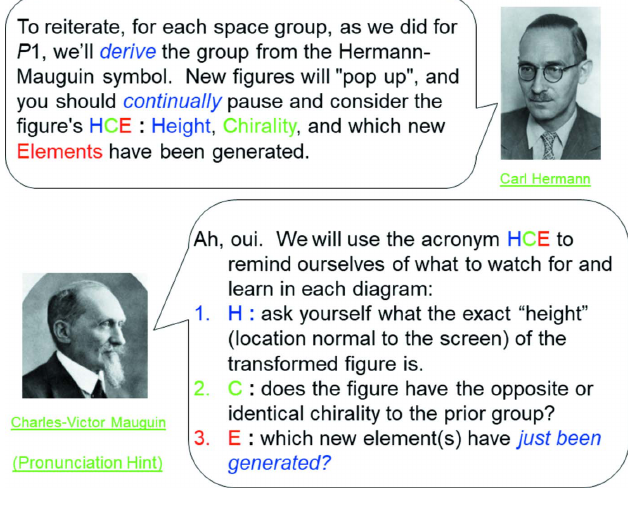
Figure 12 Slide 17, Chapter